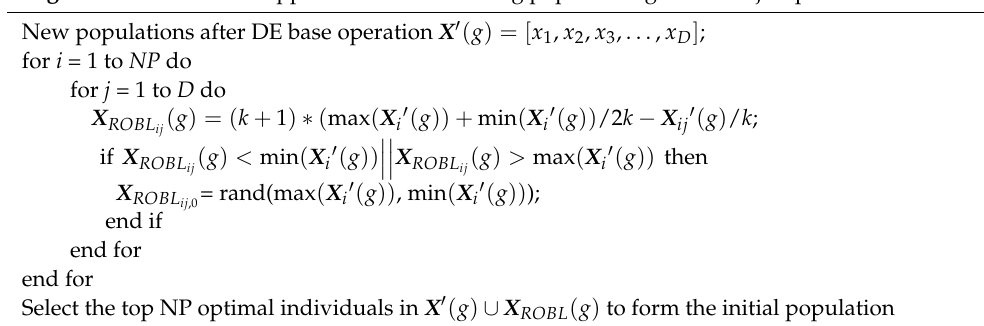
Algorithm 2 . Refractive opposition-based learning population generation